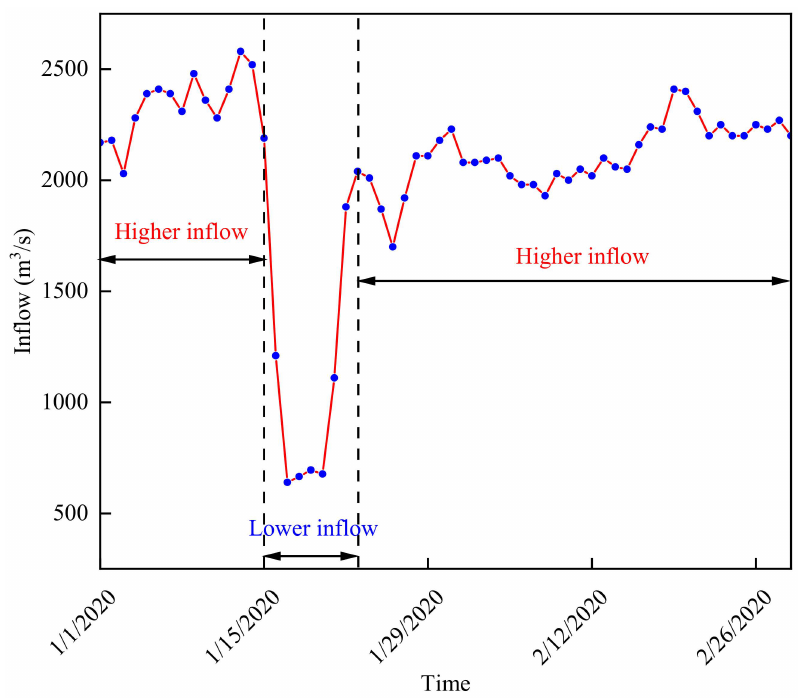
Figure 6. Inflow process of XLD from 1 January 2020 to 29 February